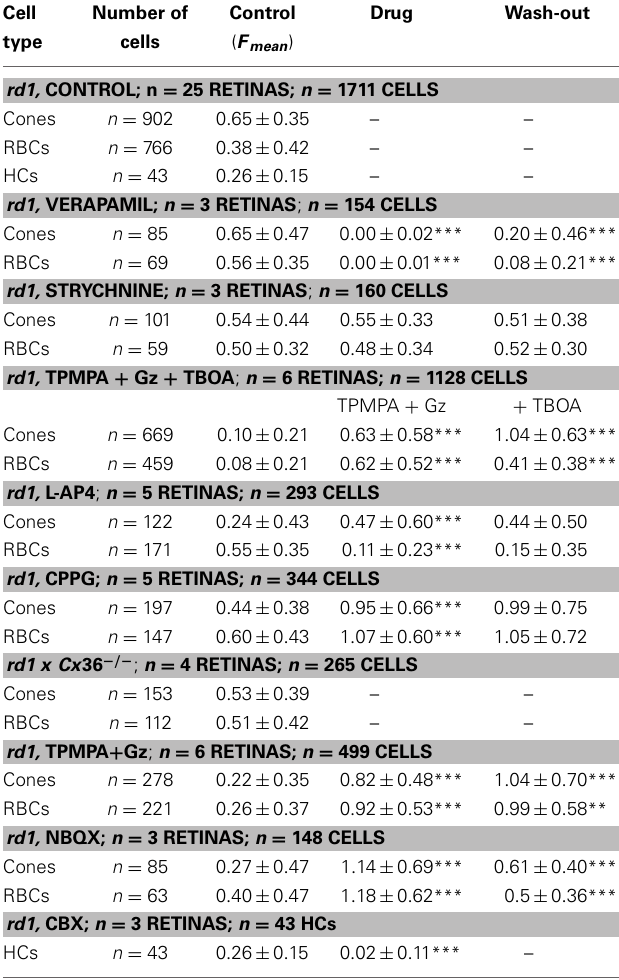
Table showing mean Ca 2 + event frequencies (in Hz) for cones, rod bipolar cells (RBCs) and horizontal cells (HCs) for control condition, during drug appli- cation and after wash-out. Statistical significance is indicated as ** p < 0.01, and *** < 0.001 (control vs. drug or wash-out conditions). Gz, Gabazine; CBX,